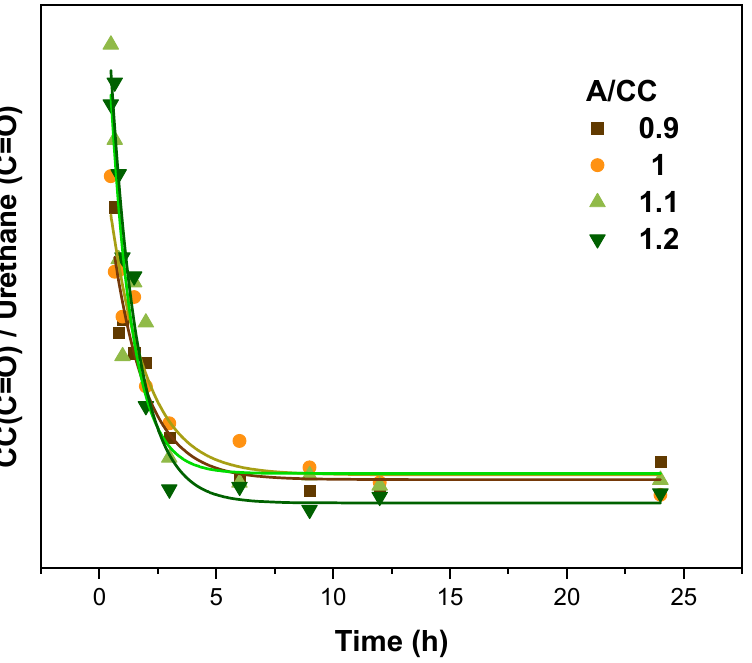
Figure 3. FT-IR integrated data for the development of the NIPU curing process. (T = 100 ◦ C, Figure 3. FT ‐ IR integrated data for the development of the NIPU curing process. (T = 100 °C, A/CC A/CC = 1, t = 0–24 h). = 1, t = 0–24 h).